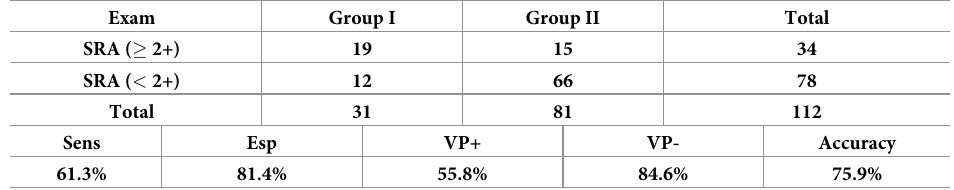
Table 4. Total number patients with two or more positive SRA results (Risk 1) in Groups I and II in the initial three hours of